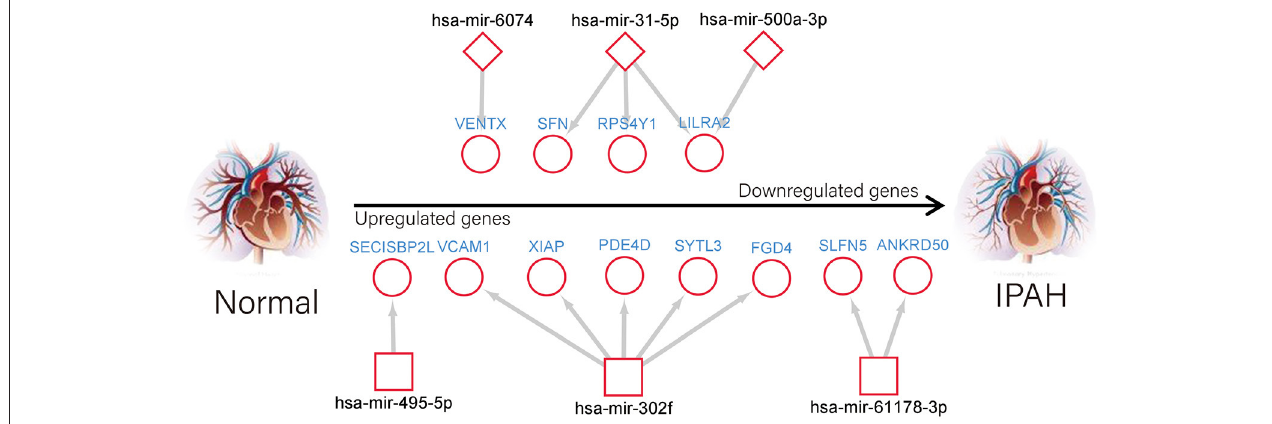
FIGURE 7 | An interactive network of overlapped genes and the upstream miRNAs.